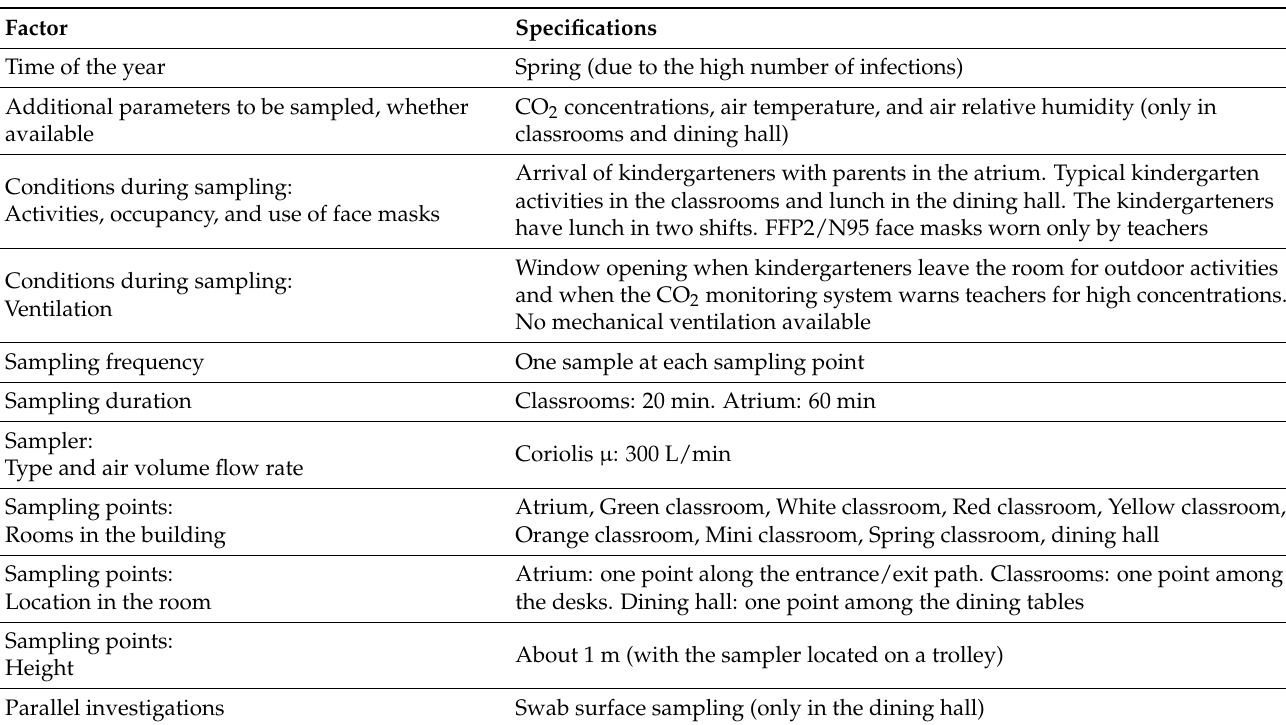
Table 2. Sampling plan for